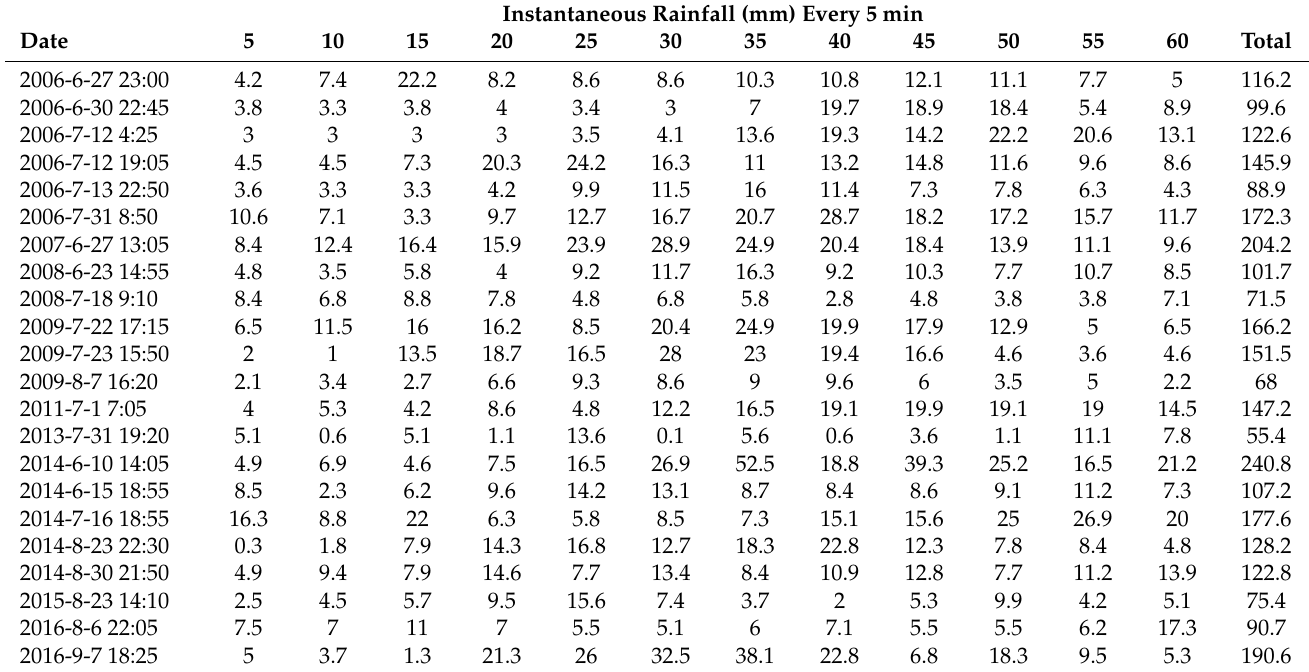
Table 1. Data for 22